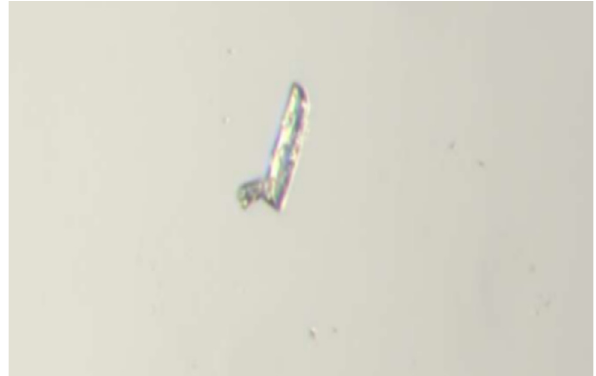
Figure 7: Grain size of salicylic